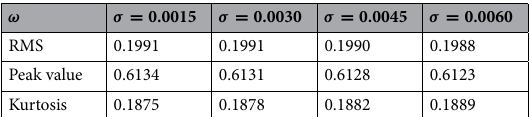
Table 3. Indicator weight under different perturbation